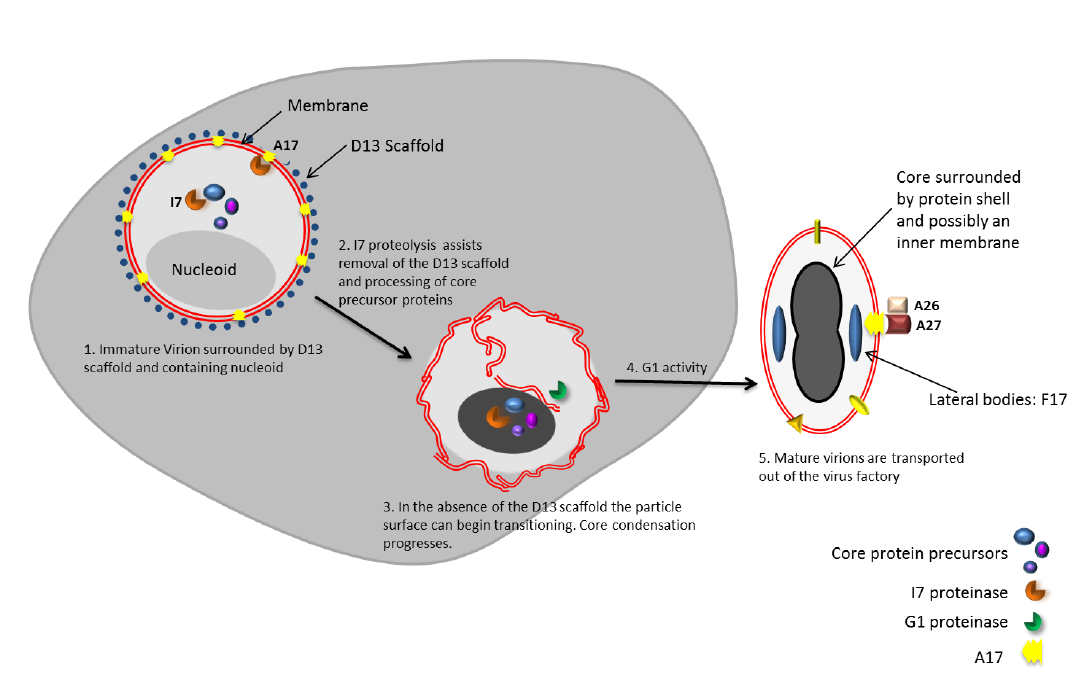
Figure 2. A summary of the transition of immature virion (IV) to mature virion (MV).